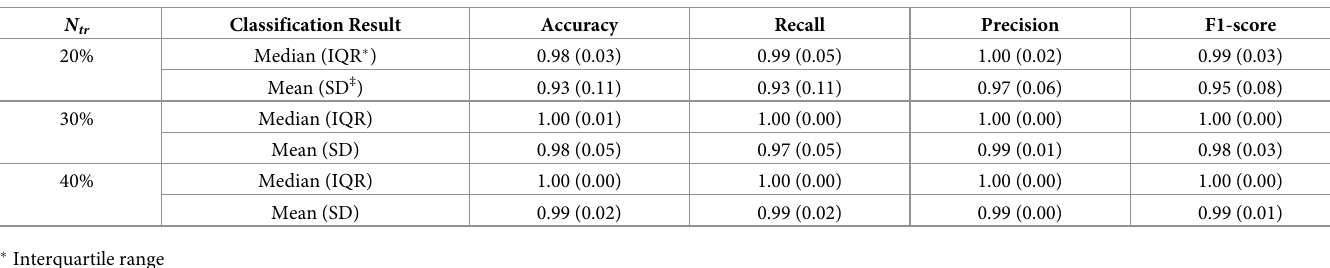
Table 3. Classification results of the hybrid model on the synthetic